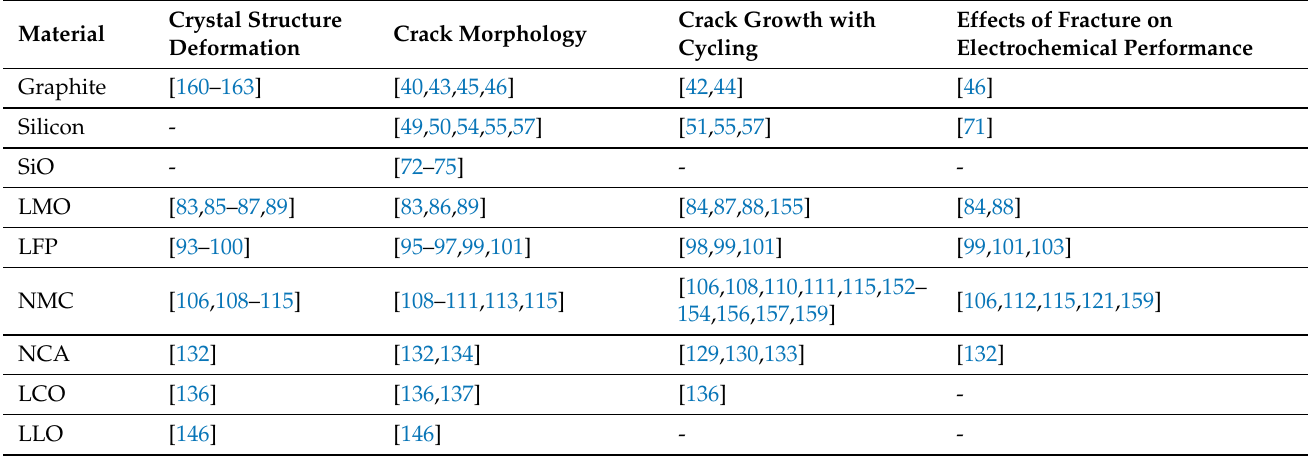
Table 3. Summary of the state-of-art of experimental fracture mechanics in the most popular active material used for LIBs